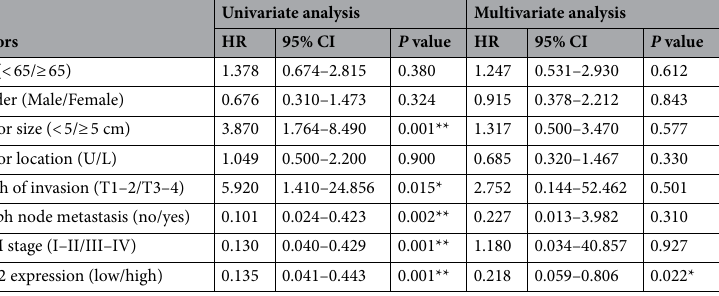
Table 2. Univariate and multivariate analysis of overall survival (Cox’s regression model). * P < 0.05,** P < 0.01. HR hazard ratio, CI confidence interval.